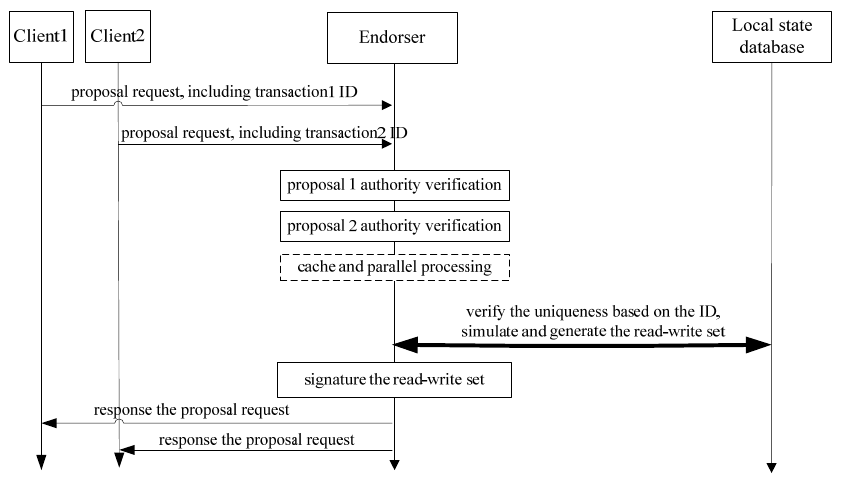
Figure 3. Optimized endorsement processing flow of Fabric.